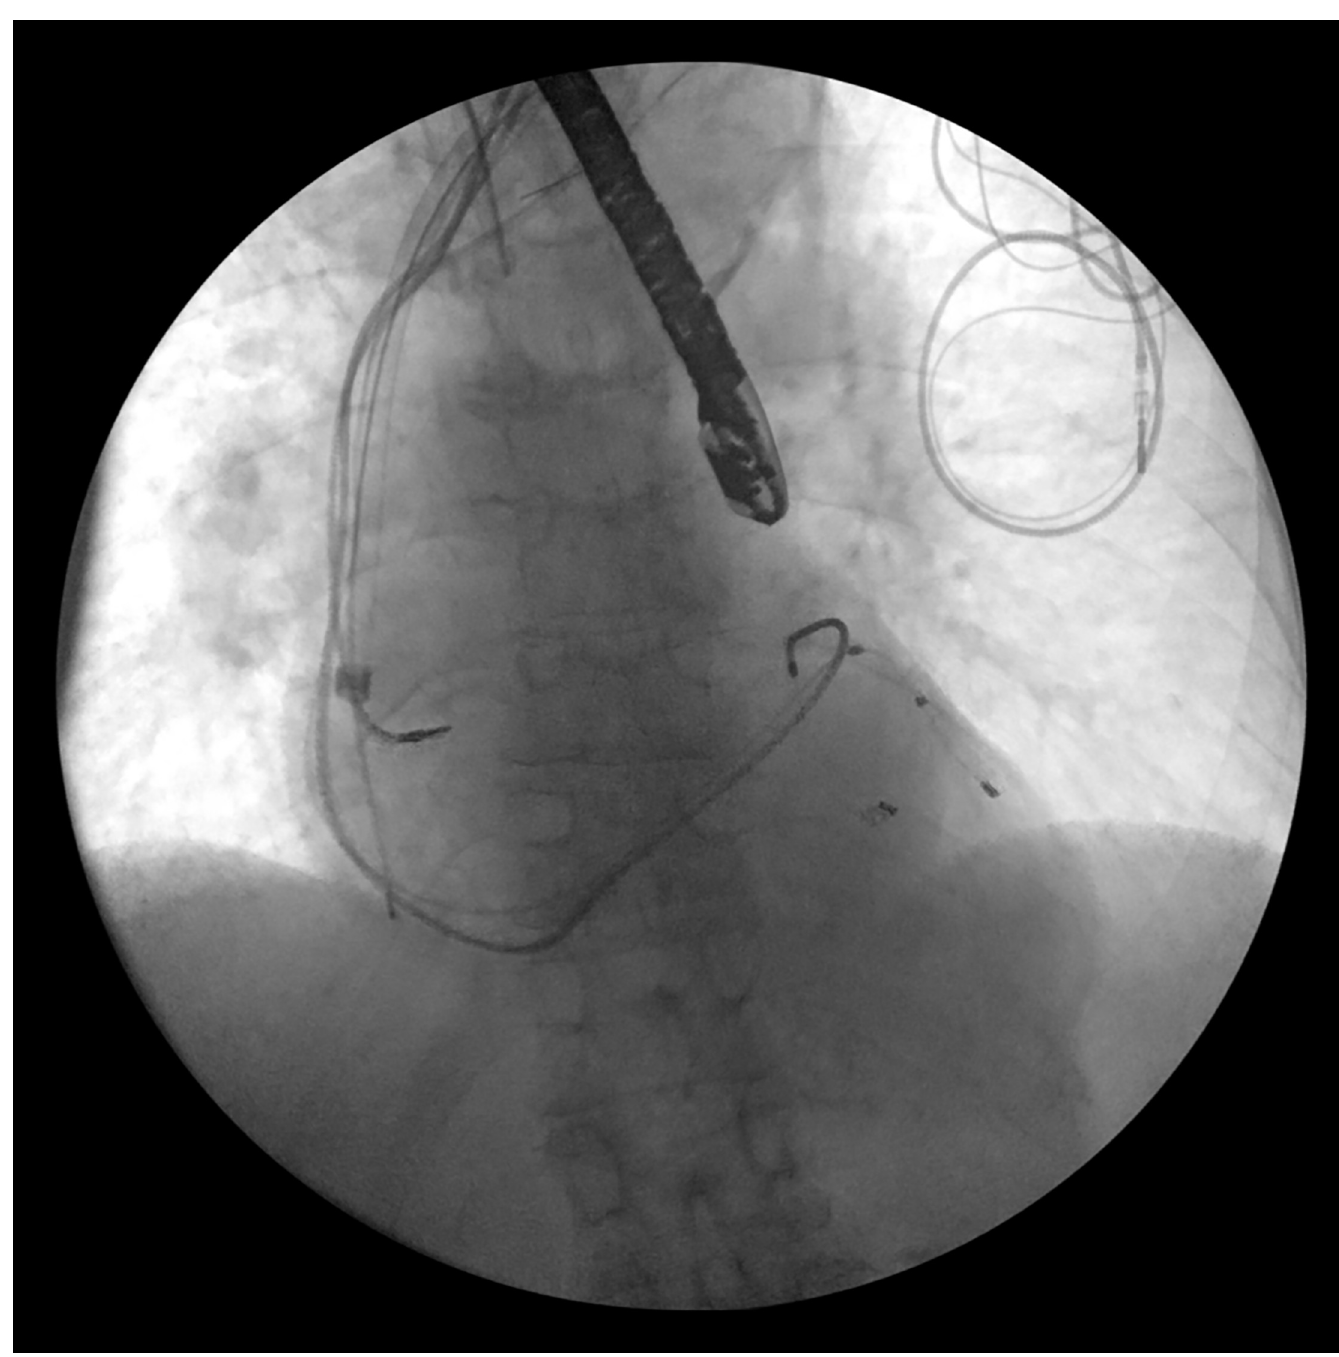
Fig 4. Extraction of the lead through the laser